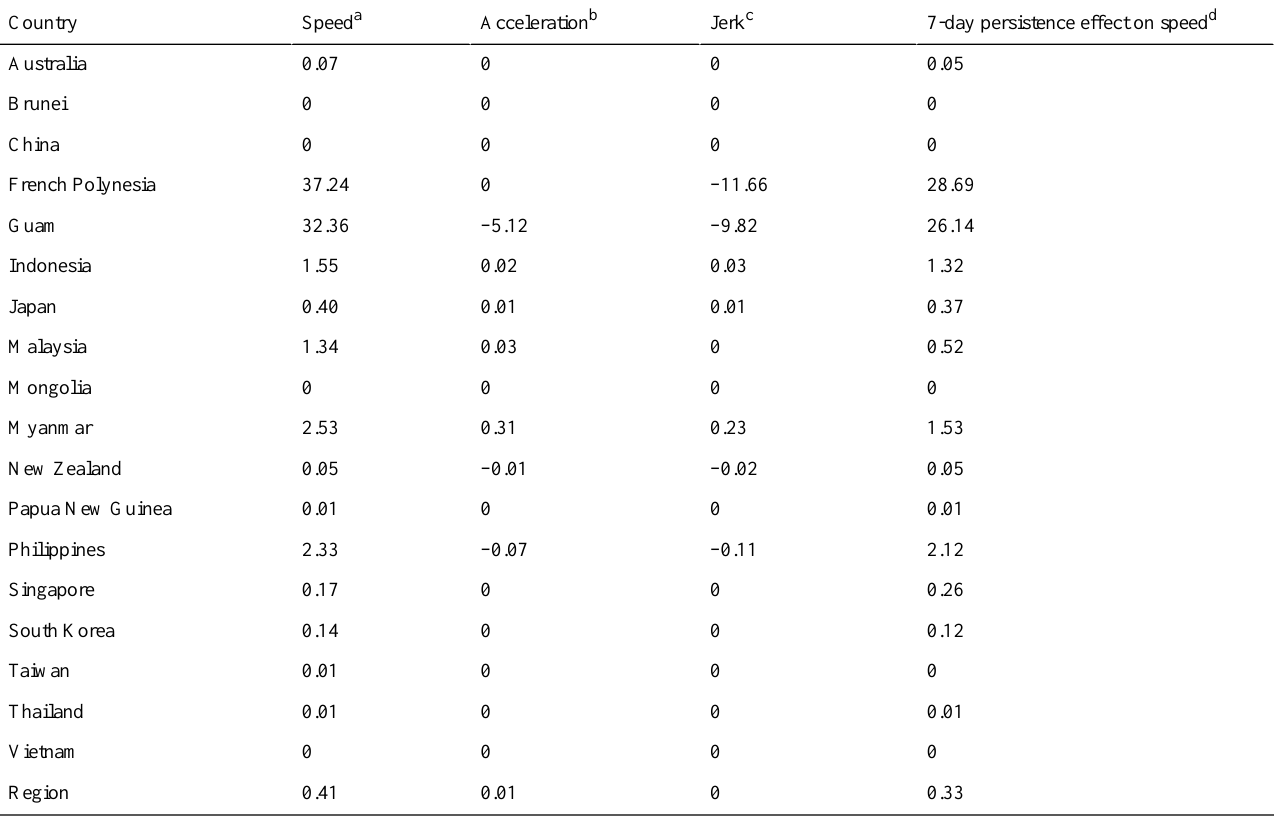
Table 4. Novel surveillance metrics for the week of October 5-11,